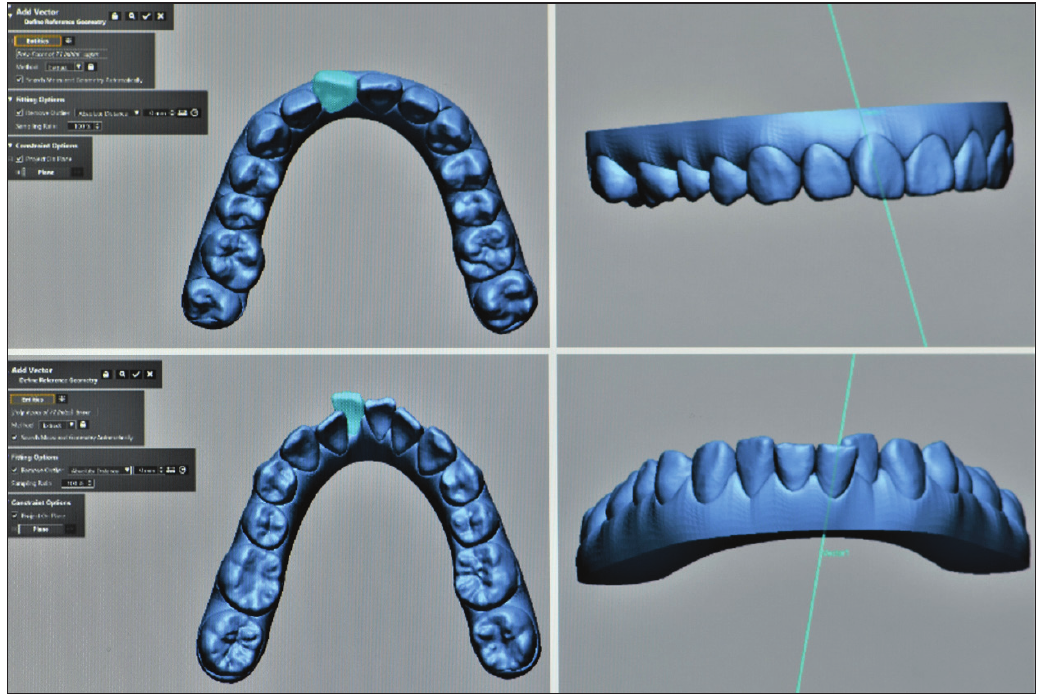
Figure 1. Generation of long axis of the